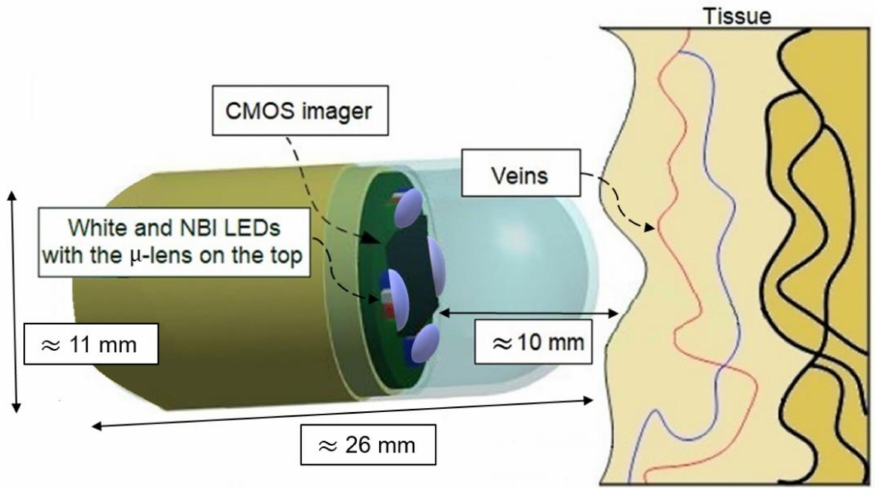
Figure 1. Artwork of an endoscopic capsule with Narrow Band Imaging (NBI) light emitting diodes (LEDs) and the polydimethylsiloxane (PDMS) u-lenses on their tops. CMOS: complementary metal-oxide